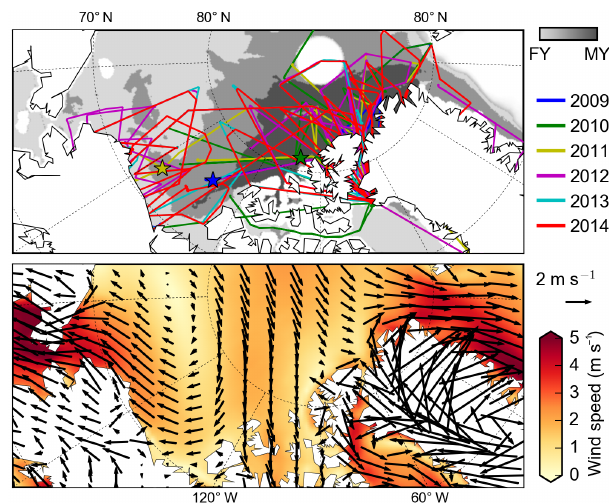
Figure 2. Top: IceBridge sea ice flight lines and estimated ice type over the western Arctic. The dark grey (light grey) background in- dicates regions where more than 80% of the daily data within all IceBridge sea ice campaign dates (across all years) are estimated as MYI (FYI), while the medium grey indicates a mix of FYI and MYI, taken from the EUMETSAT OSI-SAF ice type mask. The coloured stars indicate locations of the various case studies, as highlighted in the relevant figures. Bottom: mean winds from January to March (2009–2014) taken from the ERA-I